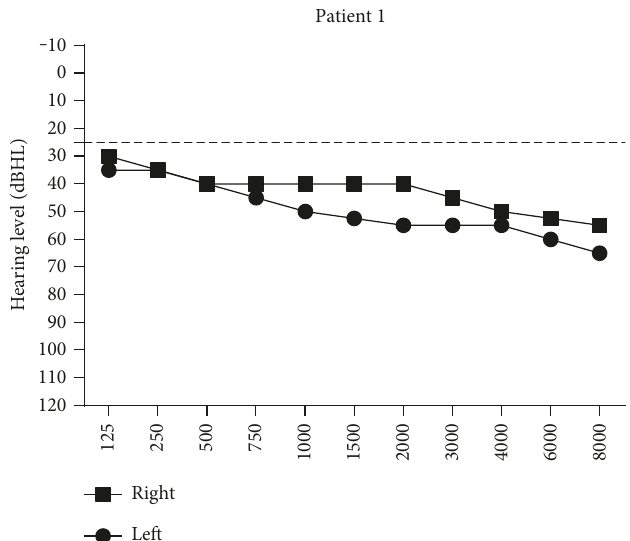
Figure 1: Bilateral pure-tone audiometry in patient 1. An ear hearing level equals or less than 25 dB was considered